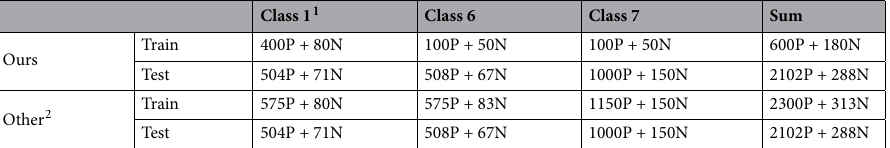
Table 1. Division of the DAGM2007 dataset. 1 Due to the wider texture variety of Class 1 images, our ISU- GAN needs to use a higher number of Class 1 images to train the model. 2 For the other models used for comparison, to obtain a stable result, we used the entire training set (including the label) officially divided by DAGM.